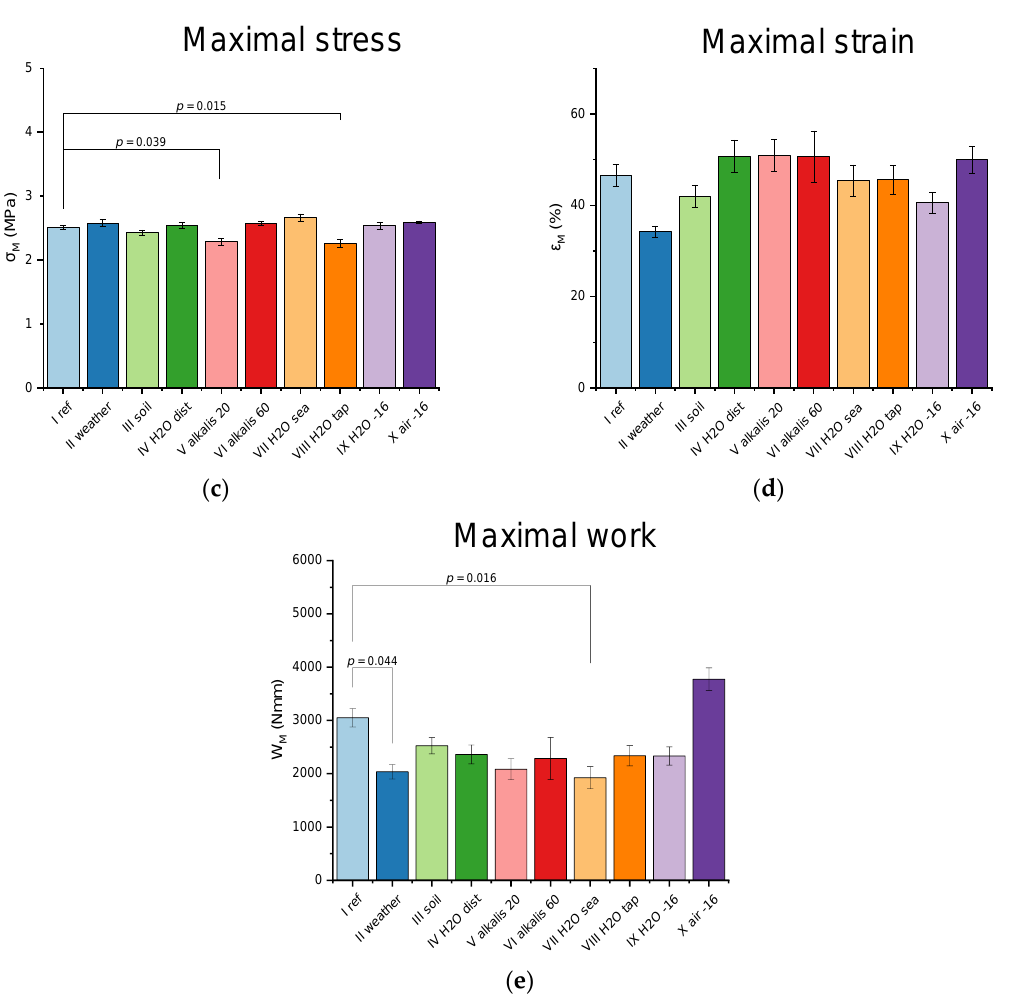
Figure 6. Results of Tukey test comparing mechanical properties—( a ) Young’s modulus, ( b ) equivalent